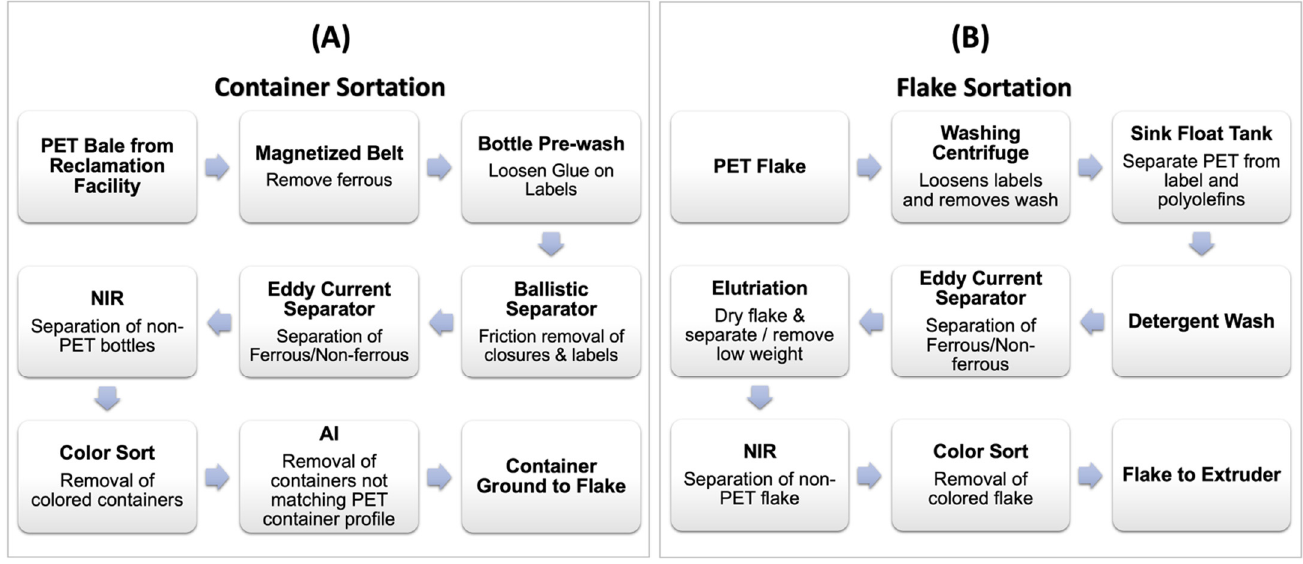
Figure 11. Unit operations in recycler: ( A ) container sortation and ( B ) flake sortation.